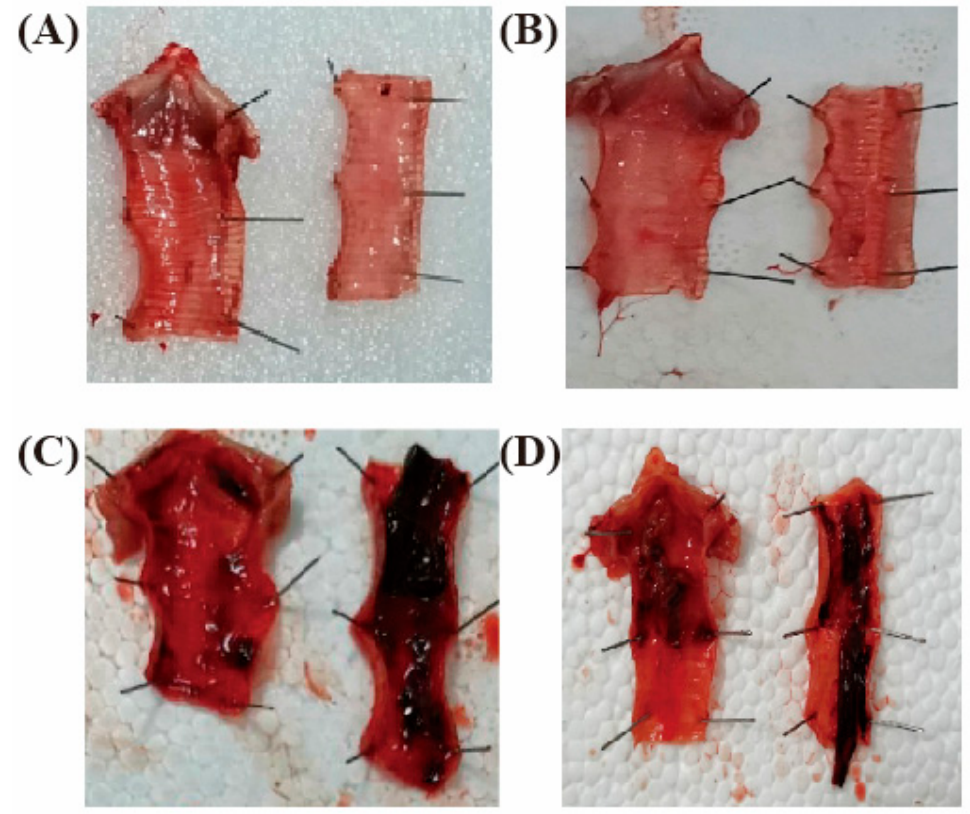
Figure 6. The pathological changes of inoculated chickens and control chickens after challenge. ( A ) rFPV-gB, ( B ) mild respiratory cases from the crFPV, ( C ) control group, ( D ) acute respiratory cases from the crFPV. ( A , B ) Larynx and trachea with congestion and bleeding, ( C , D ) larynx and trachea with embolism of bloody exudate.